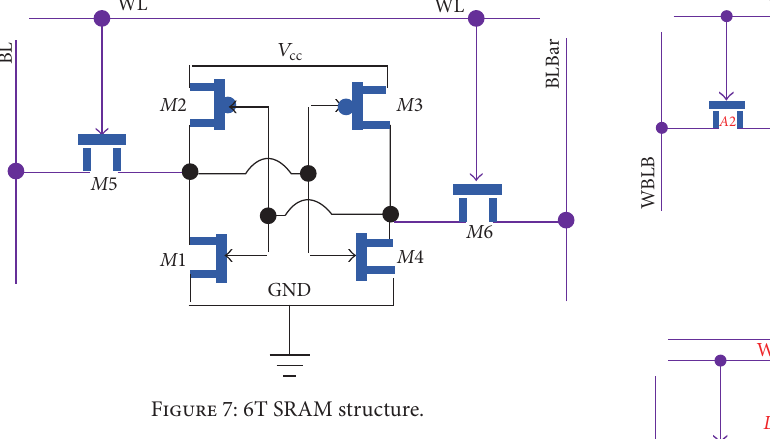
Figure 9: 8T SRAM structure.